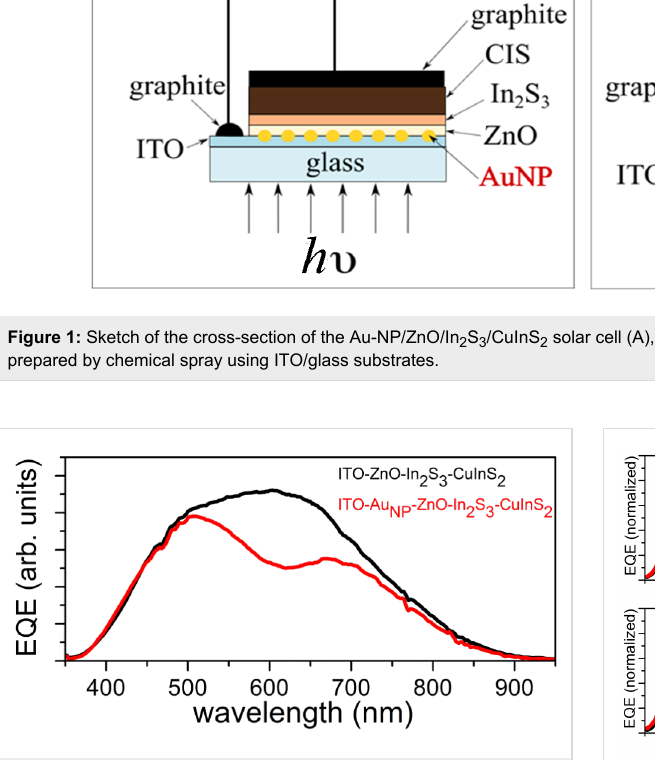
Figure 2: External quantum efficiency (EQE) of a plasmonic solar cell employing Au-NPs on top of an ITO layer. The EQE of the cells without the Au-NP layer is indicated with black lines. The volume of the solu- tion of the Au-NP precursor was 2.5 mL.